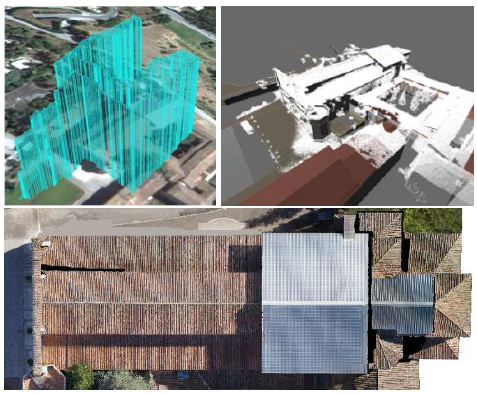
Figure 5. The creation of a true-orthophoto from